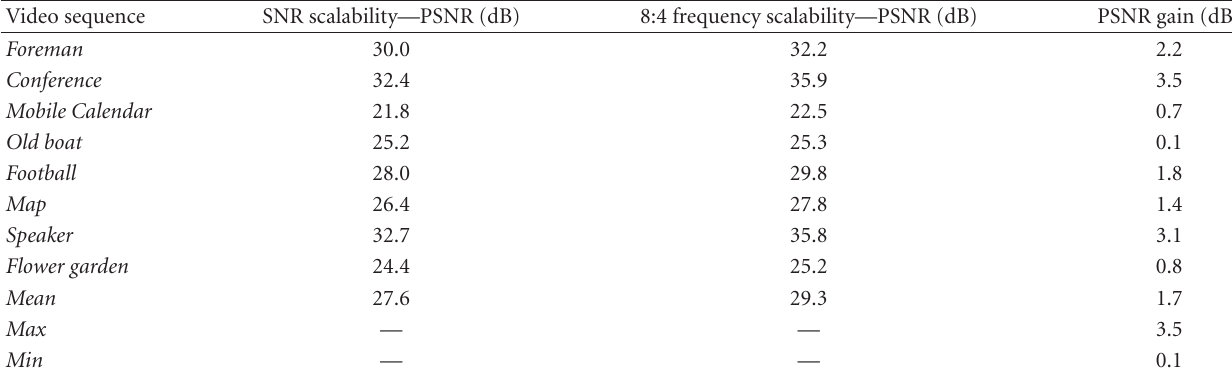
Table 2: Comparison of PSNR results for di ff erent intracoded images and same protection rate.